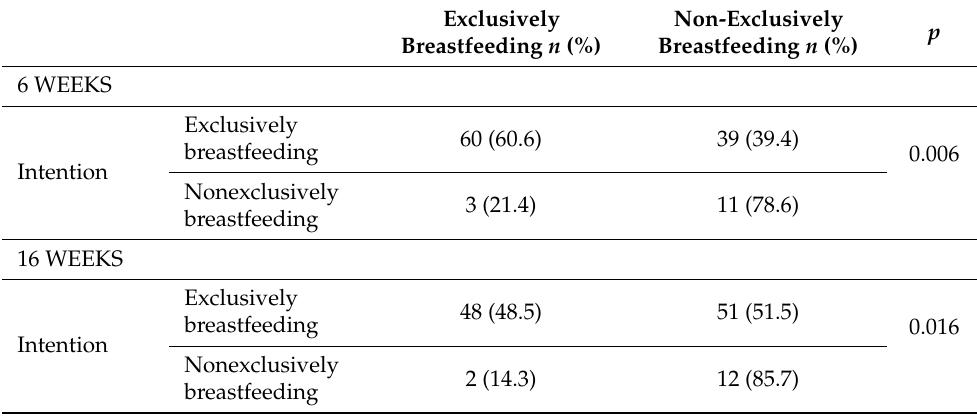
Table 6. Breastfeeding intentions among participants who initiated exclusive breastfeeding compared to those who did not at 6 weeks, 16 weeks and 6